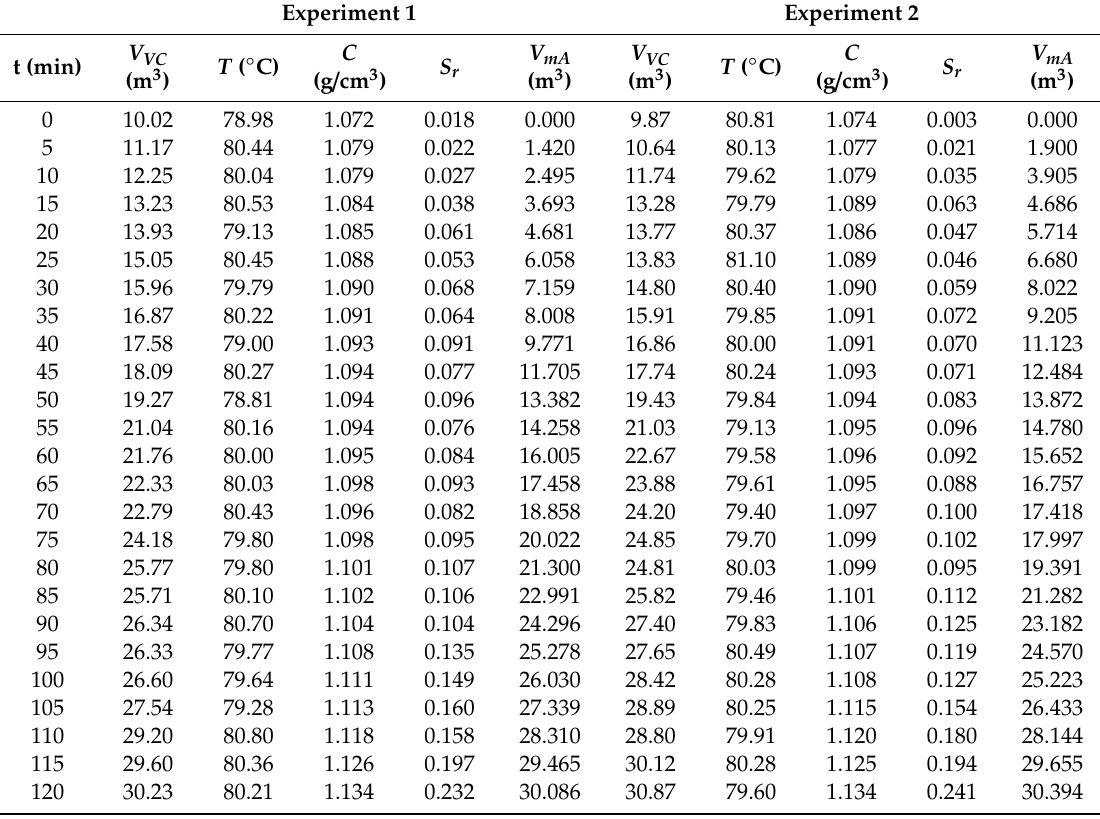
Table 4. Operational data from experiments 1 and 2 ( V mA is